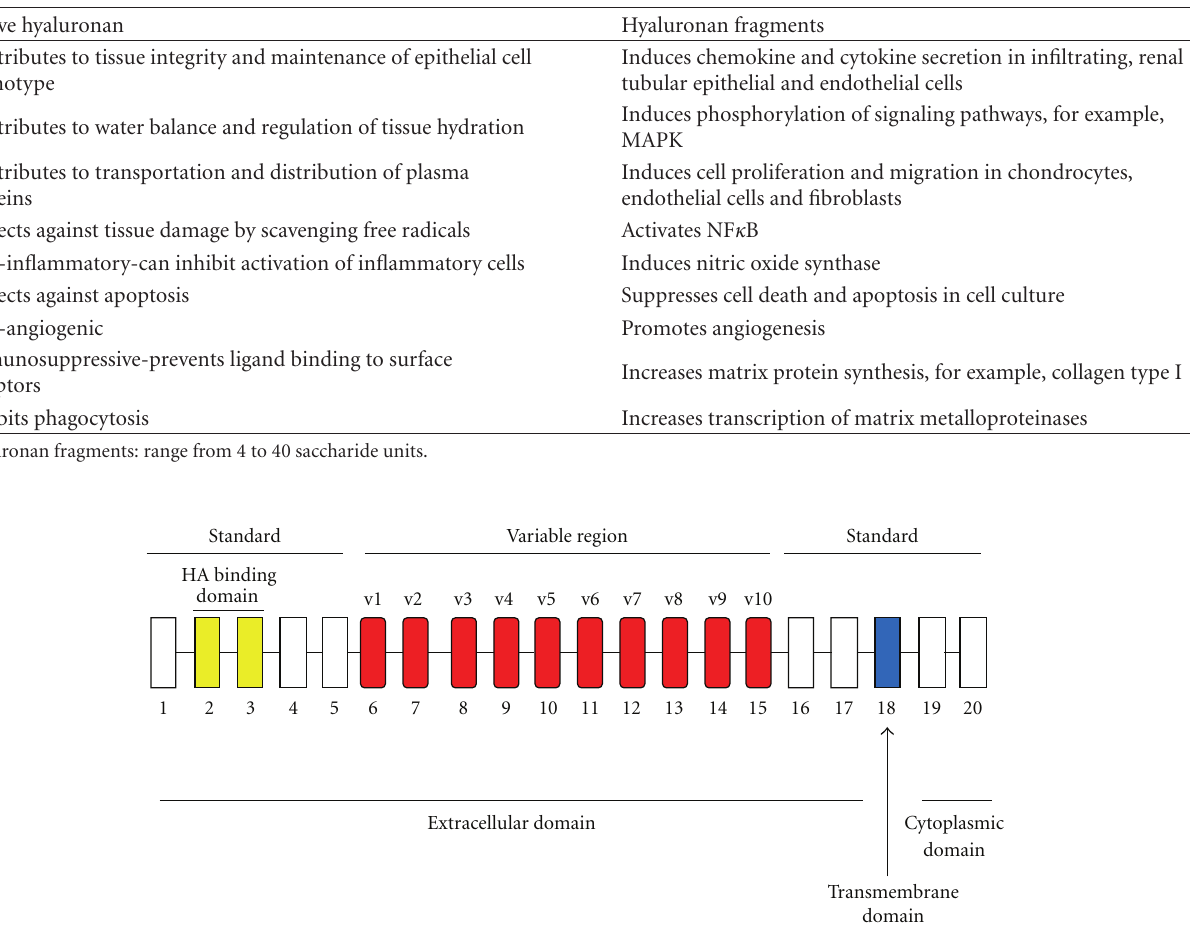
Figure 1: Genomic structure of CD44. The gene encoding for human CD44 consists of 20 exons. The standard form of CD44 contains